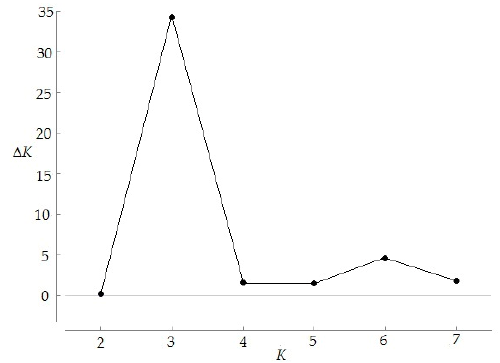
Figure 2. Relations between the rational groups number K and estimated value Δ K.